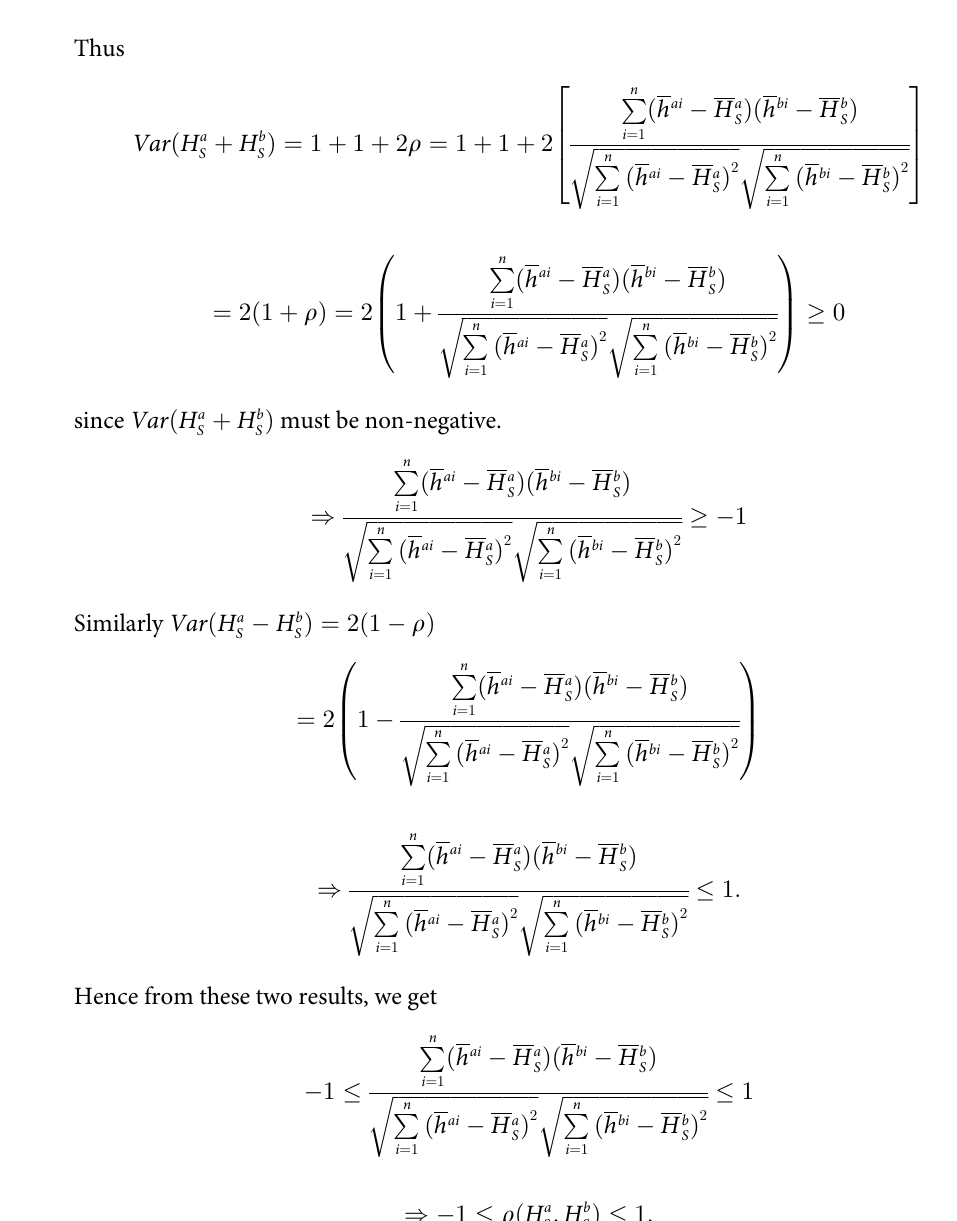
ffiffiffiffiffiffiffiffiffiffiffiffiffiffiffiffiffiffiffiffiffiffiffiffiffiffiffiffiffiffiffiffi P n